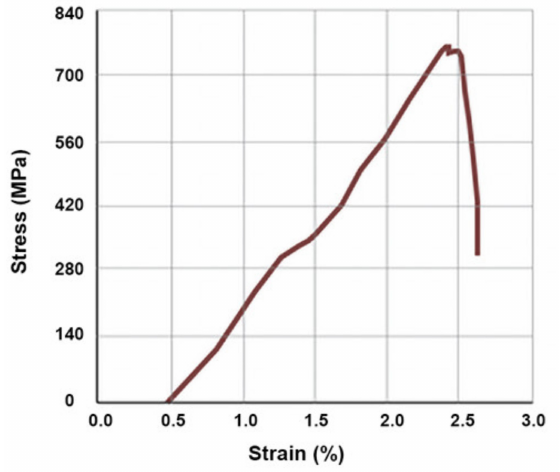
Figure 6. Typical stress-strain curve for basalt fiber at room